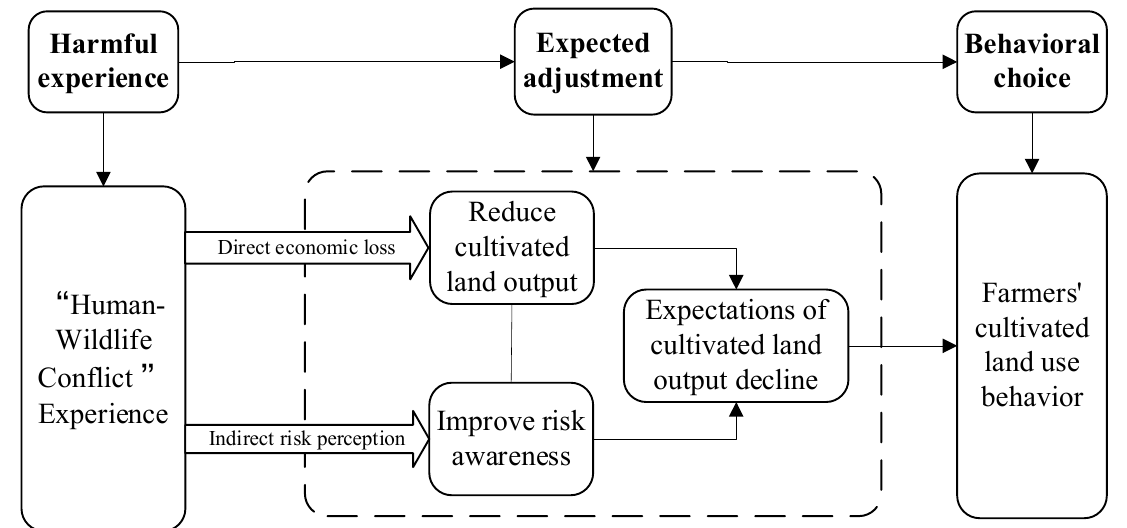
Figure 1. Theoretical framework underlying the impact of HWC experience on cultivated land use behaviour